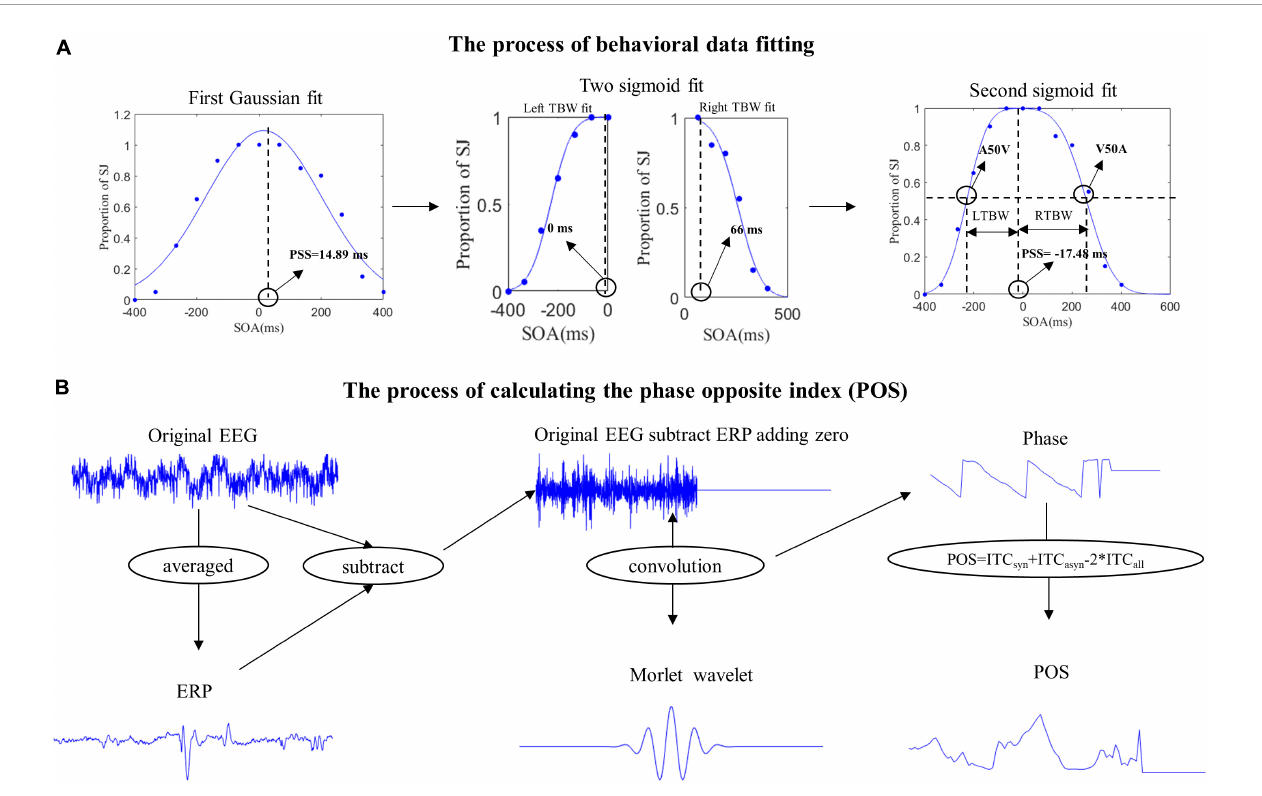
FIGURE2 The pipelines of behavior data fitting and calculating phase opposite index (POS). (A) We first fitted the Gaussian curve to get the point of subjective simultaneity (PSS). Then two sigmoid curves were fitted with the stimulus onset asynchronous (SOAs) located to the left and right of the PSS to get the new PSS, A50V, and V50A thresholds. The left temporal binding window (LTBW) was defined as the difference between PSS and A50V. The right temporal binding window (RTBW) was defined as the difference between PSS and V50A. (B) In our experiment, evoked activities were induced from the white central cross to the onset of the video and from the visual face onset to the visual preparatory movement onset. To exclude the effect of evoked activity on the ongoing induced activity, we first computed the ERP (the time-domain trial average) and then subtracted the ERP from the original EEG signal on each trial. This was done separately for each SOA condition, electrode, and subject. Then we padded all data points after zero the amplitude value of zero µ V to exclude the poststimulus effects temporally smearing back to the prestimulus interval. Furthermore, we used Morlet wavelets to extract the phase of ongoing EEG oscillations and quantified the phase opposite between synchronous and asynchronous response with the POS.